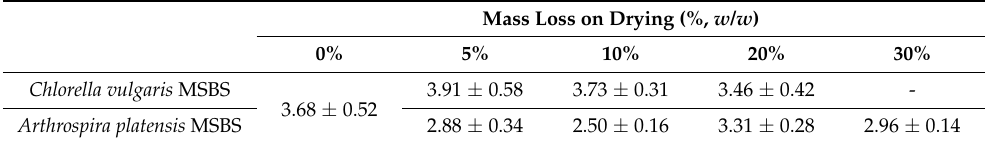
Table 3. Loss on drying (%, w / w ) for MSBS samples with different levels of biomass content.